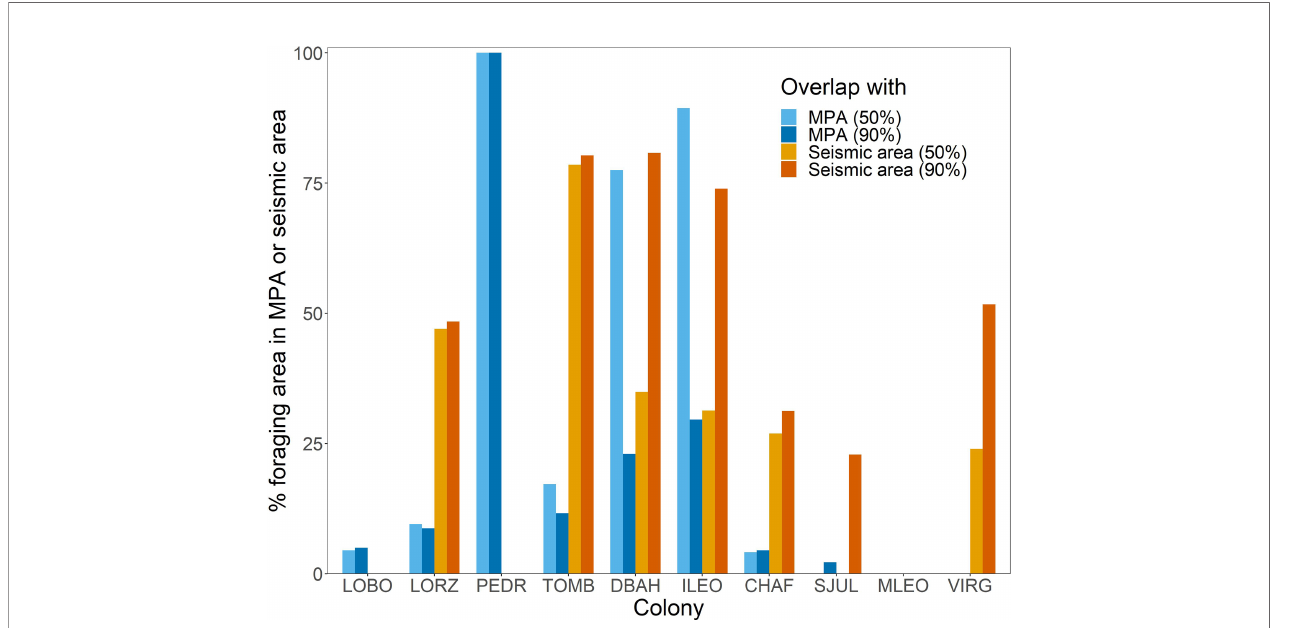
FIGURE 3 | The percentage of Magellanic penguin foraging area contained within marine protected areas (MPA) or seismic-survey areas (Seismic area) varied among colonies in Argentina. 50% = overlap of 50% UD kernel contours with MPAs or seismic-survey areas; 90% = overlap of 90% UD kernel contours with MPAs or seismic-survey areas. LOBO, Complejo Islote Lobos; LORZ, Estancia San Lorenzo; PEDR, El Pedral; TOMB, Punta Tombo; DBAH, Cabo Dos Bah ı ́ as; ILEO, Isla Leones; CHAF, Isla Chaffers; SJUL, San Julia ́ n; MLEO, Monte Leo ́ n; VIRG, Cabo V ı ́ rgenes. See Table S3 for MPAs that overlap each colony ’ s foraging area and Figure 4 for locations of